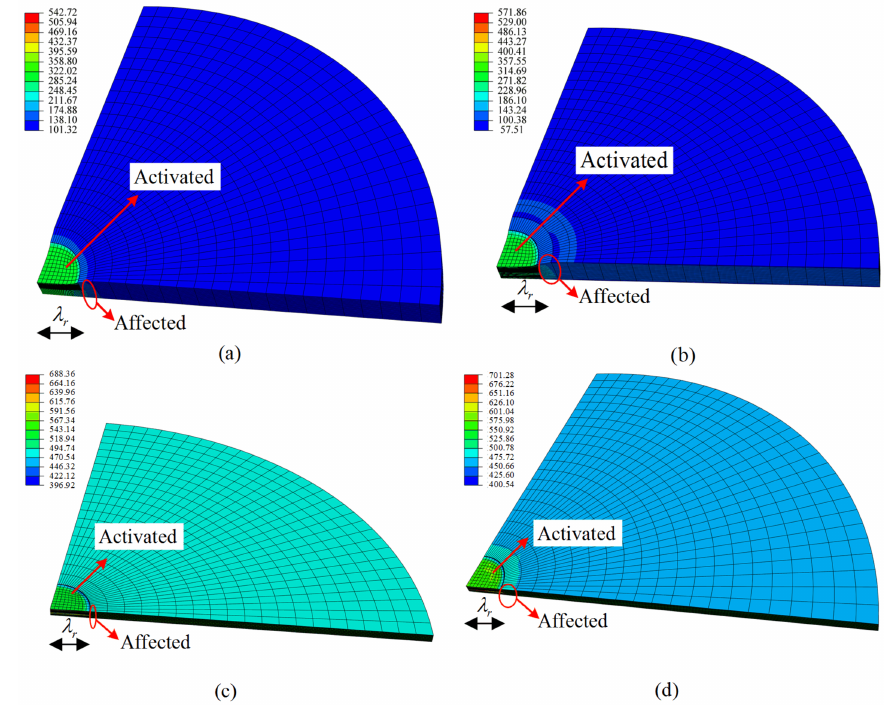
Figure 12. Simulation results of quarter model of the circular dielectric elastomer at time t = 300 s: ( a ) Yeoh model λ pre , r = 3 and V = 2000 V; ( b ) Modified model λ pre , r = 3 and V = 2000 V; ( c ) Yeoh model λ pre , r = 5 and V = 3000 V; ( d ) Modified model λ pre , r = 5 and V = 3000